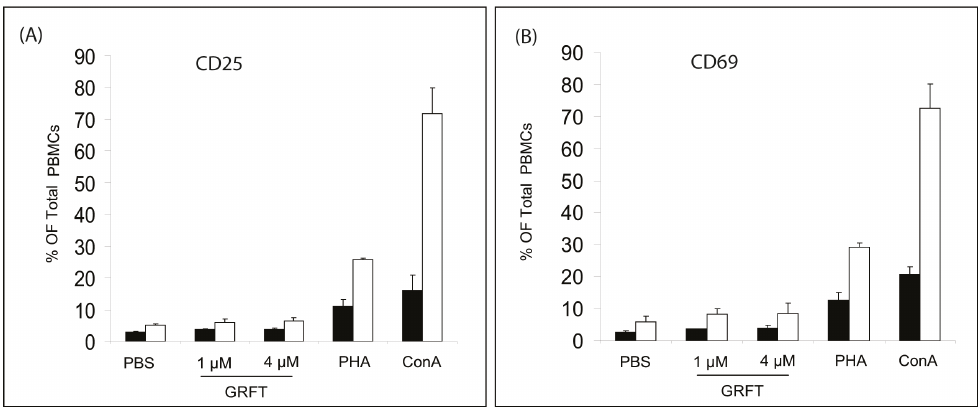
Figure 3. Effect of GRFT on the expression of cell surface activation markers in mPBMCs. Flow cytometry was performed after dual fluorescent staining with fluorescein isothiocyanate (FITC) ‐ conjugated rat anti ‐ CD4 mAb in combination with phycoerythrin (PE) ‐ conjugated rat anti ‐ CD25 or hamster anti ‐ CD69. Cells were incubated in presence of PBS, 1 and 4 μ M GRFT 0.37 μ M ConA and 10 μ g/mL PHA as indicated. ( A ) Represents the percentages of CD4+/CD25+ (black columns) and total CD25+ (white columns), whereas CD4+/CD69+ (black columns) and total CD69+ (white columns) ratios were plotted in ( B